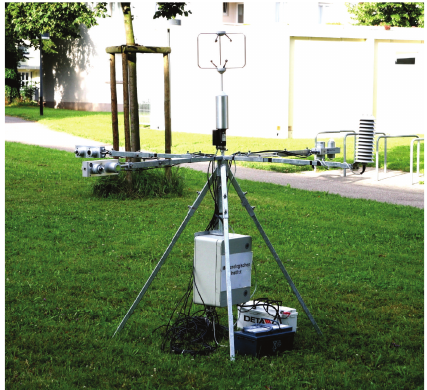
Figure 5: Stationary human-biometeorological station for exper- imental investigations to determine 𝑇 structures in